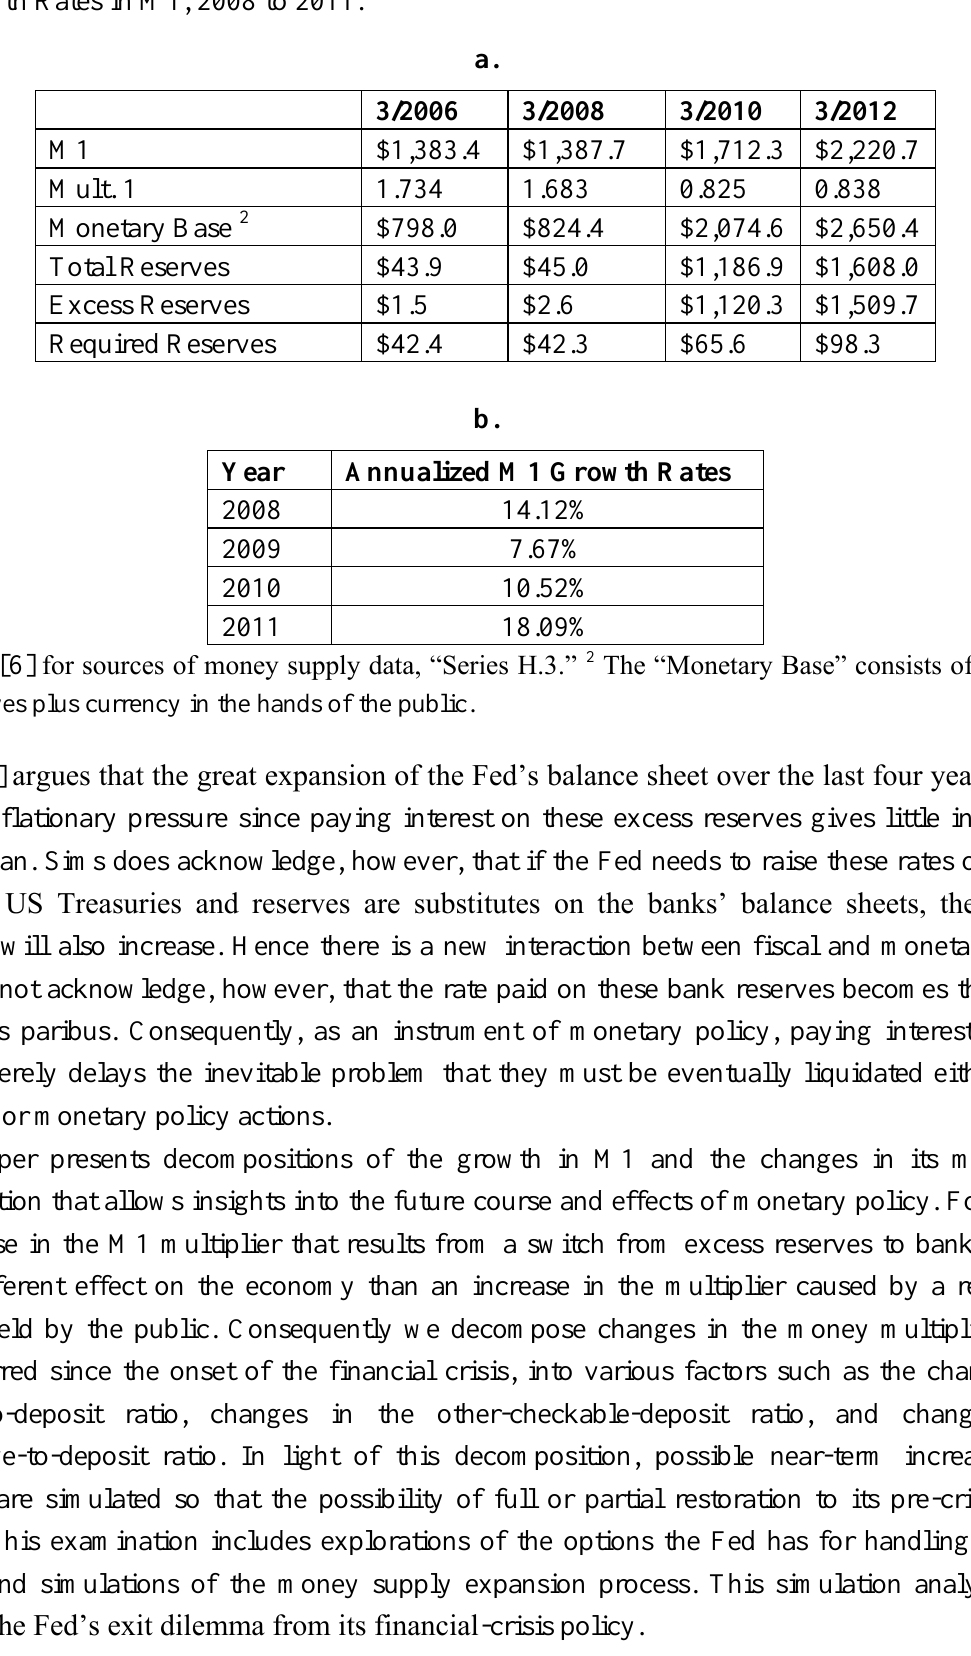
Table 1. a. Money Supply Components (in $billions except for Mult. 1) 1 . b. Annualized Growth Rates in M1, 2008 to